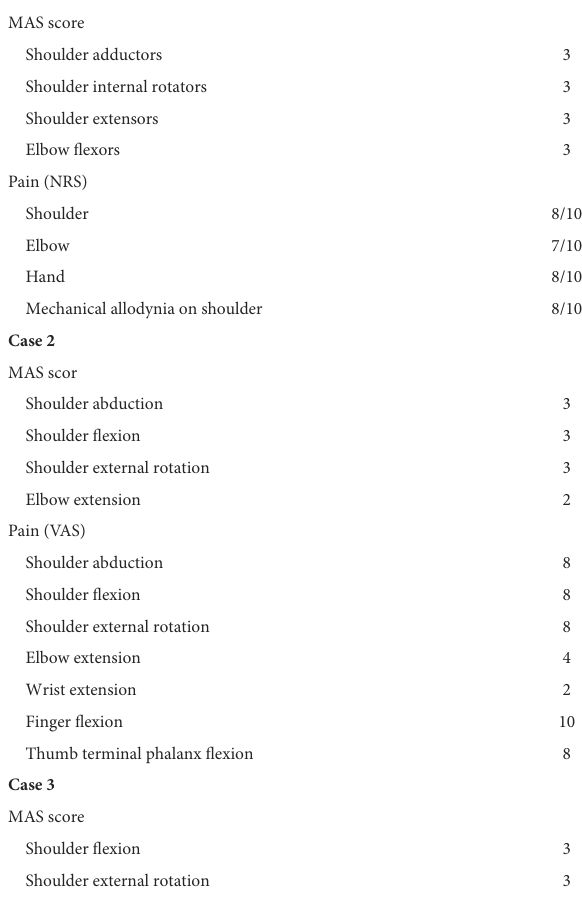
TABLE 1 Case reports: Baseline